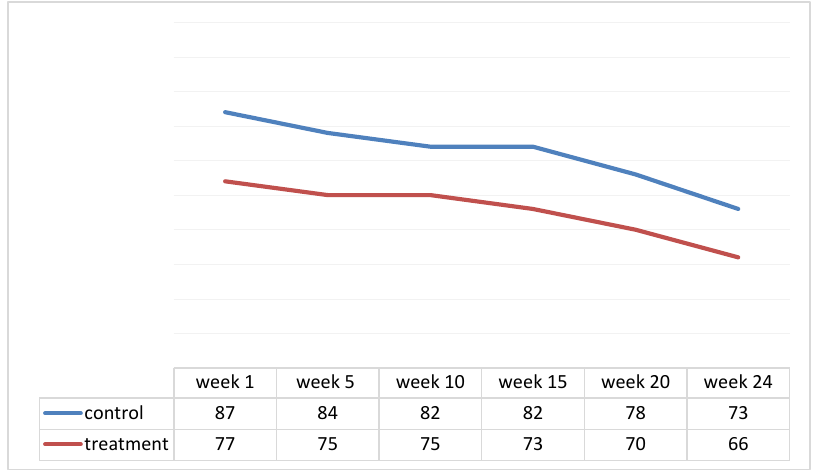
Figure 2. Comparison of the diastolic blood pressure in two groups in different